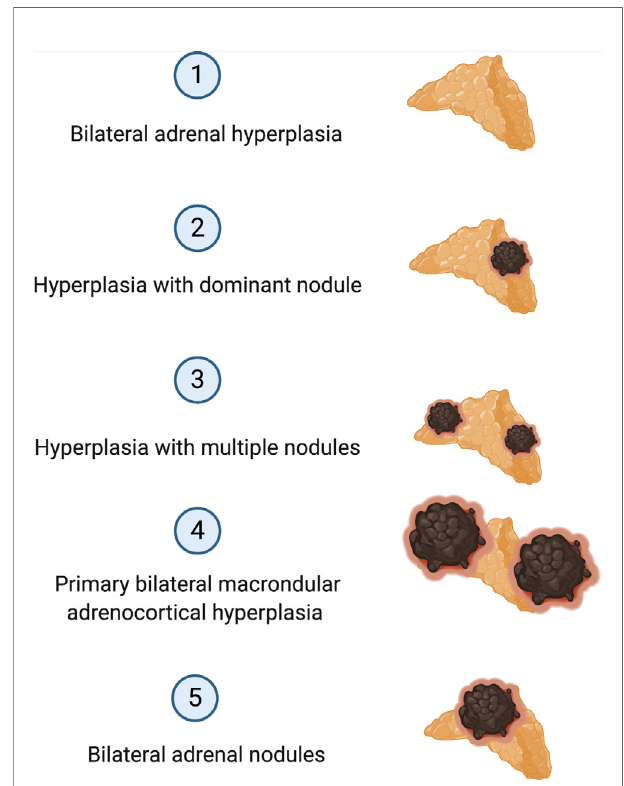
FIGURE 2 | Histologic Classi fi cation of Primary